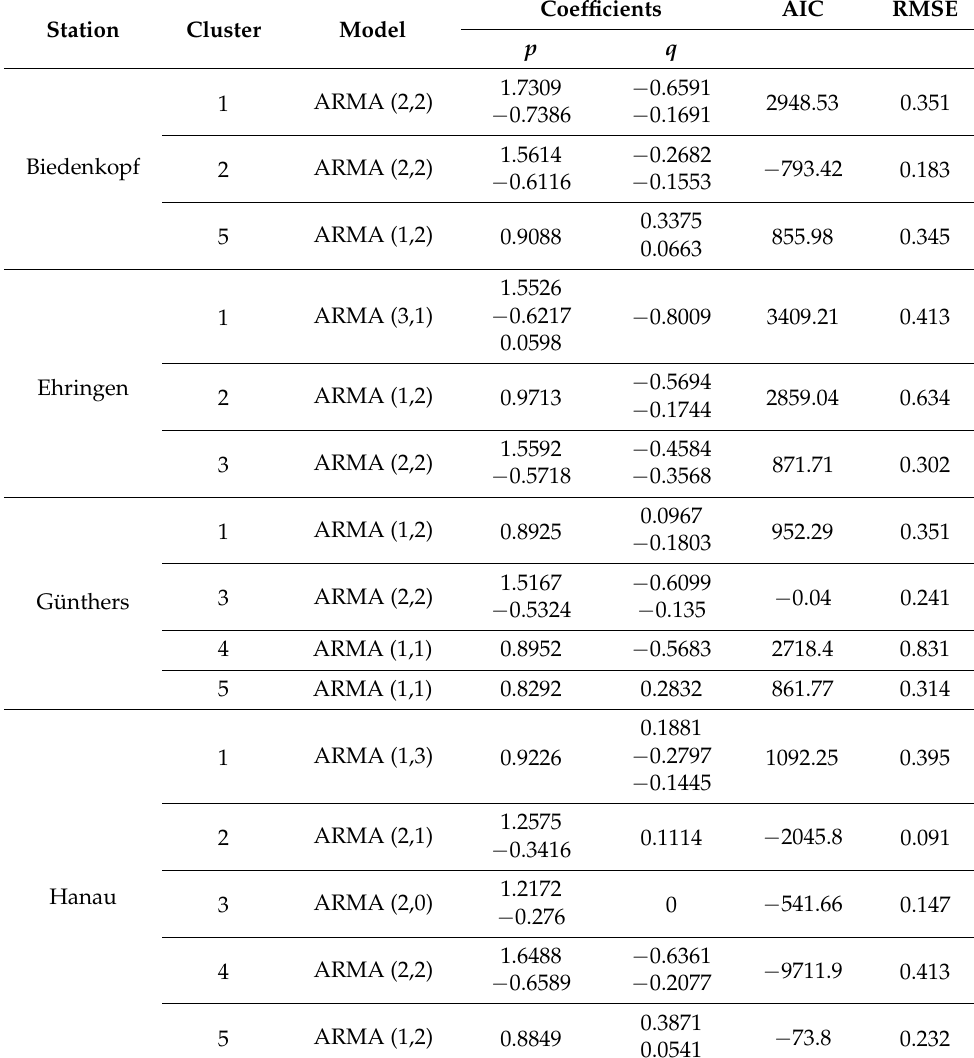
Table 4. Summary of ARMA model